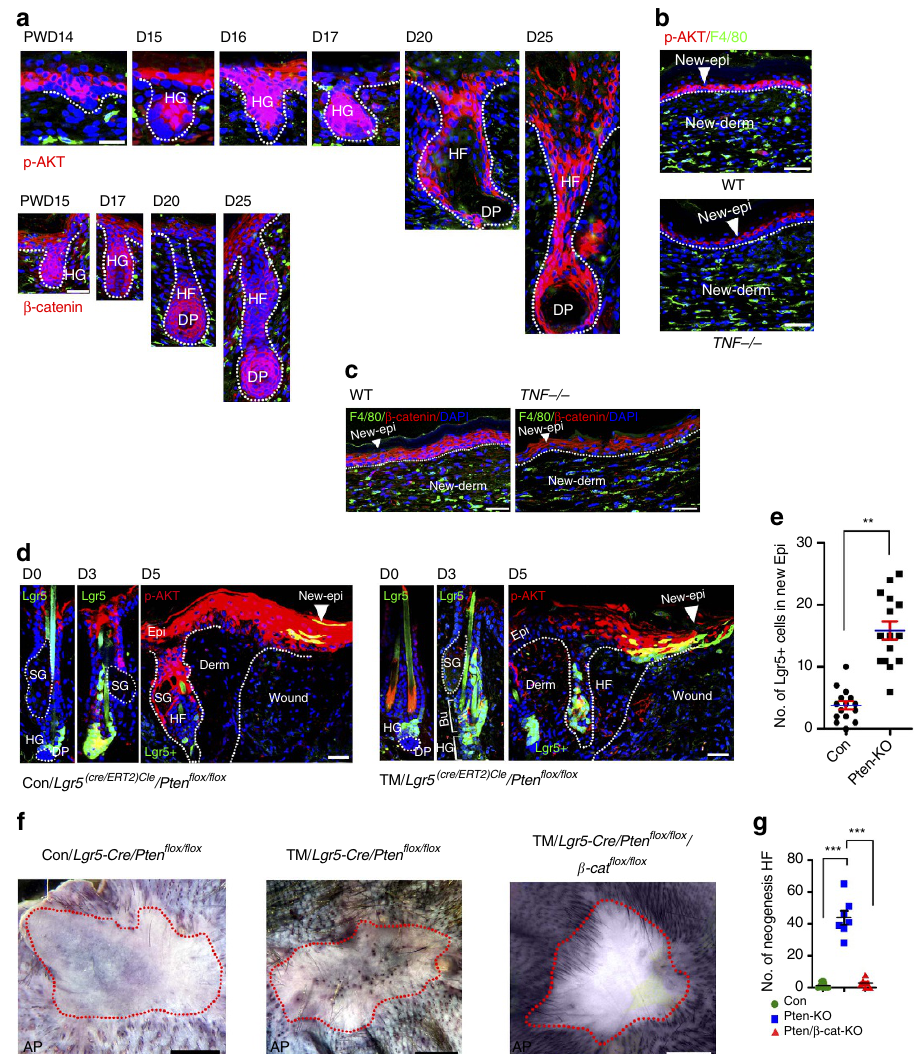
Figure 6 | AKT activation in Lgr5 þ cells promotes de novo hair regeneration. ( a ) New hair follicles in the wound began to form after PWD-14, and marked p-AKT was detected in the newly formed epidermis and in the hair germ (HG) that initiated hair follicle (HF) neogenesis. Similar to the p-AKT signal, abundant b -catenin was also detected. Scale bars, 30 m m. ( b , c ) p-AKT and b -catenin in the epidermis of re-epithelialized wounds of TNFA (cid:2) / (cid:2) and WTmice at PWD-20. Scale bars, 50 m m. ( d , e ) Lgr5 þ stem cells (GFP þ ) were present in the upper portion of the hair follicle at PWD-3 and in the re-epithelialized epidermis at PWD-5 in Pten knockout and the control mice ( d ). The number of GFP þ cells in the new epidermis of the two different groups was counted ( e ). n ¼ 15 tissue sections from 5 mice in each group were analysed. Scale bars, 50 m m. ( f , g ) Pten knockout in Lgr5 þ cells promoted de novo HF regeneration, and synchronous knockout of b -catenin with Pten completely attenuated the Pten loss-induced hair follicle neogenesis in the wound ( f ). Then, the number of neogenic HFs in different groups was quantified ( g ). n ¼ 8 for tamoxifen-treated mice; n ¼ 9 for control mice. Scale bars, 1mm. Bu, budge; SG, sebaceous gland; HG, hair germ; DP, dermal papilla. Data are expressed as the mean ± s.e.m. ** P o 0.01. *** P o 0.005, unpaired t -test,